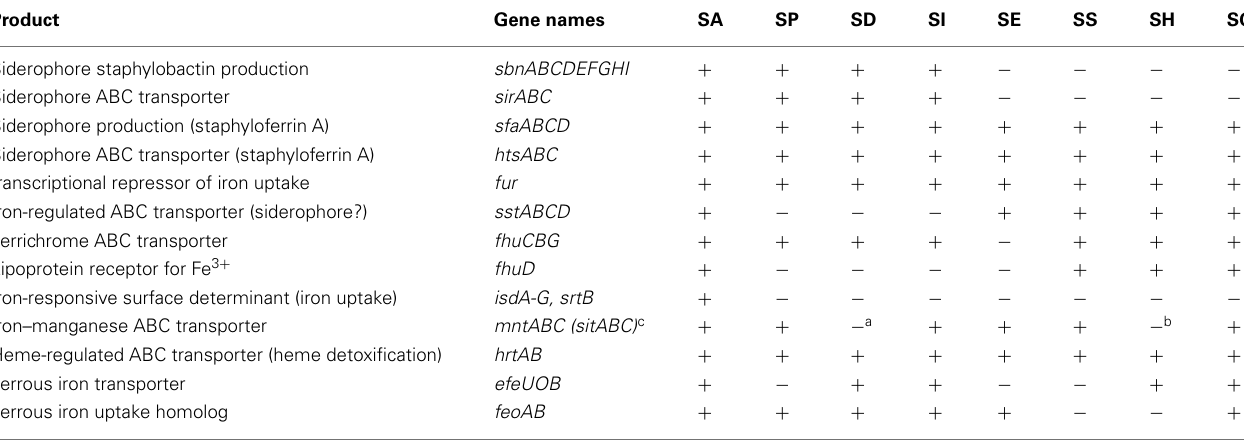
Table 3 | Distribution of iron transport related genes identified in eight staphylococcal species.